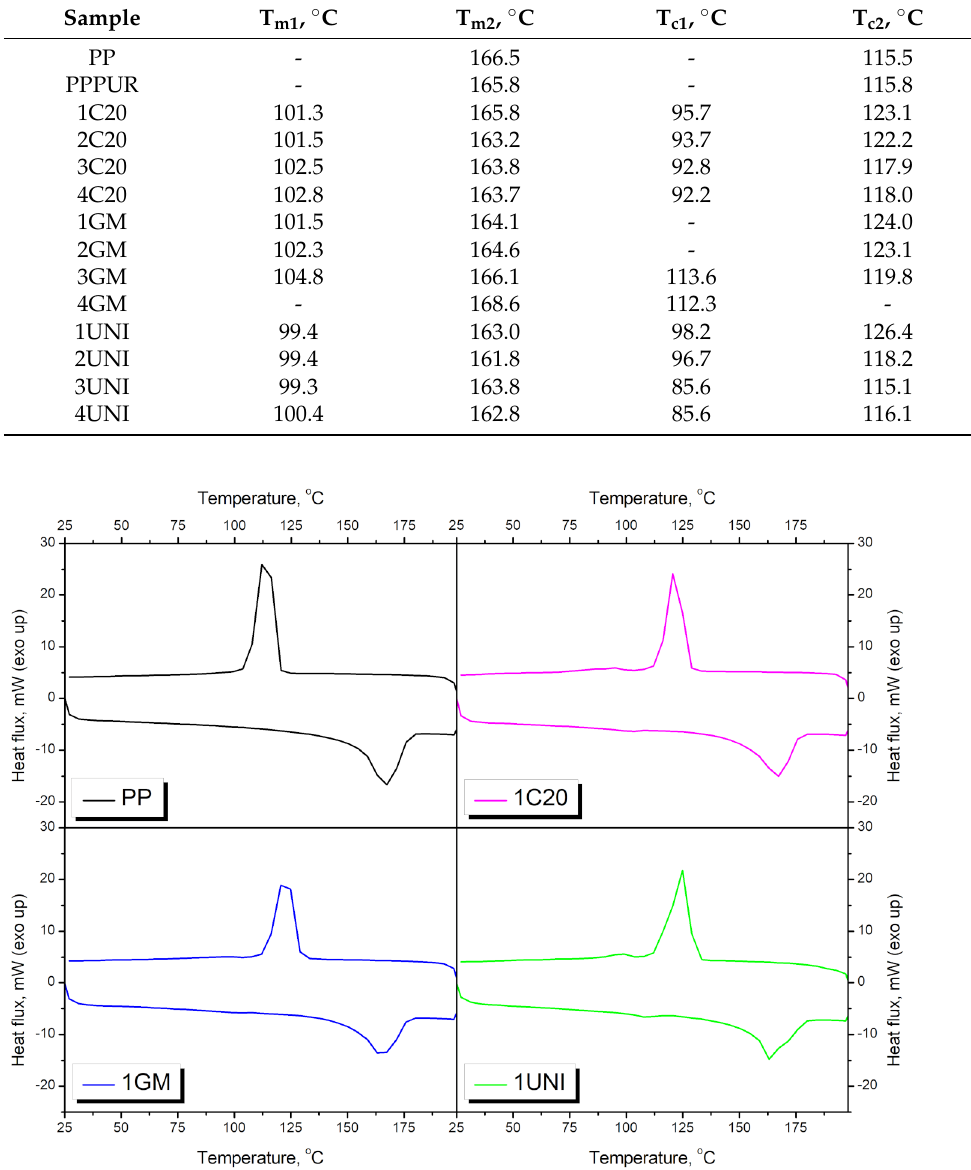
Table 3. Results obtained from the DSC analysis of the prepared materials.